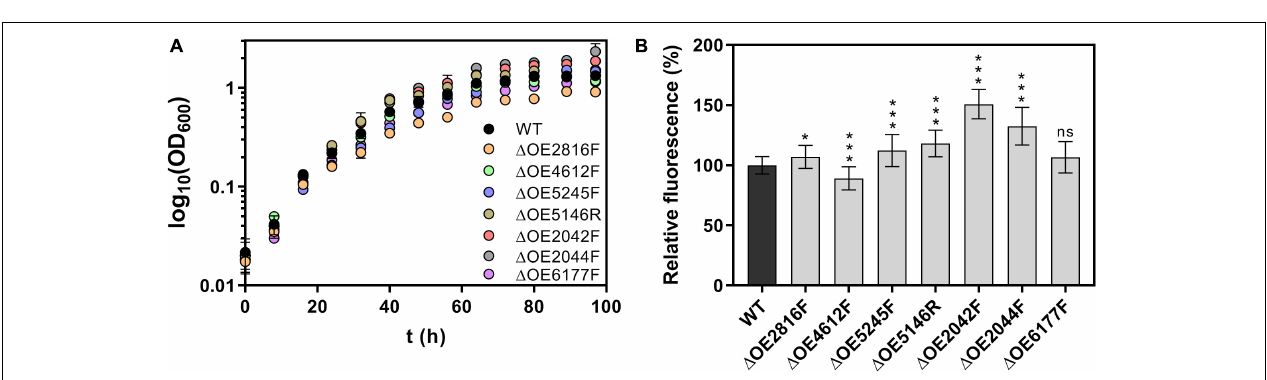
FIGURE 5 | Statistical visualization of the protein abundances after copper and nickel treatment compared to the control in (A) planktonic and (B) biofilm samples. Proteins are ranked in a volcano plot according to their p -value and their relative abundance ratio between copper/nickel treated and control samples. Proteins with p -values < 0.05 and fold changes (FC) ≤ 0.5 and ≥ 2, respectively, are shown in Venn diagrams illustrating the number of equal and unique proteins after copper and nickel treatment. Arrows up indicate increased (FC > 2) and arrows down indicate decreased (FC < 0.5) protein abundances compared to the control.